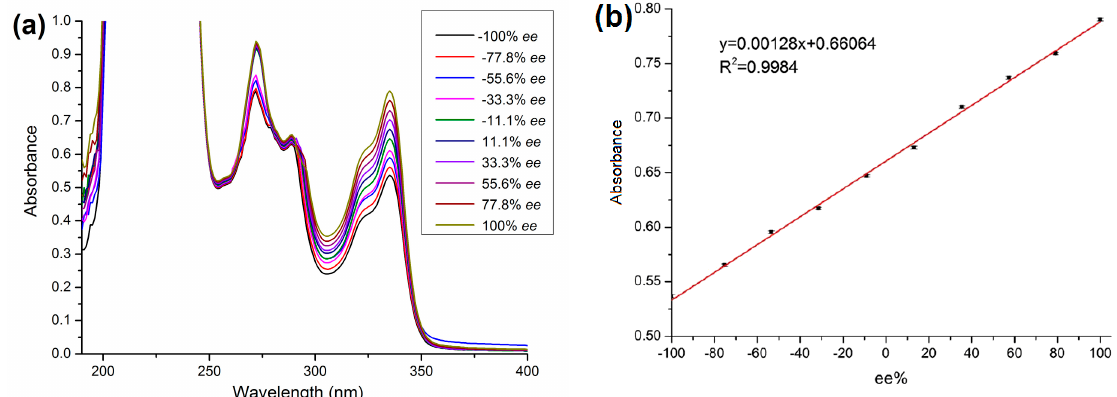
Figure 9. ( a ) UV-visible spectra of the eluates after extraction of (±)-1,1 ′ -bi-2-naphthol at various ee values; ( b ) standard curve showing the linearity of ee% with the absorbance of the eluates.